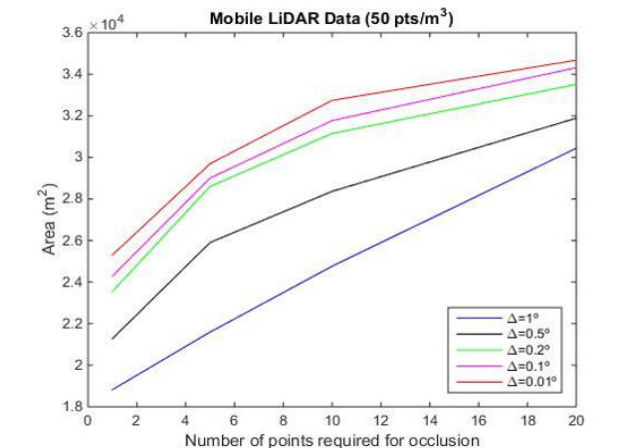
Figure 9. Different curves representing the area of visibility in function of the occlusion